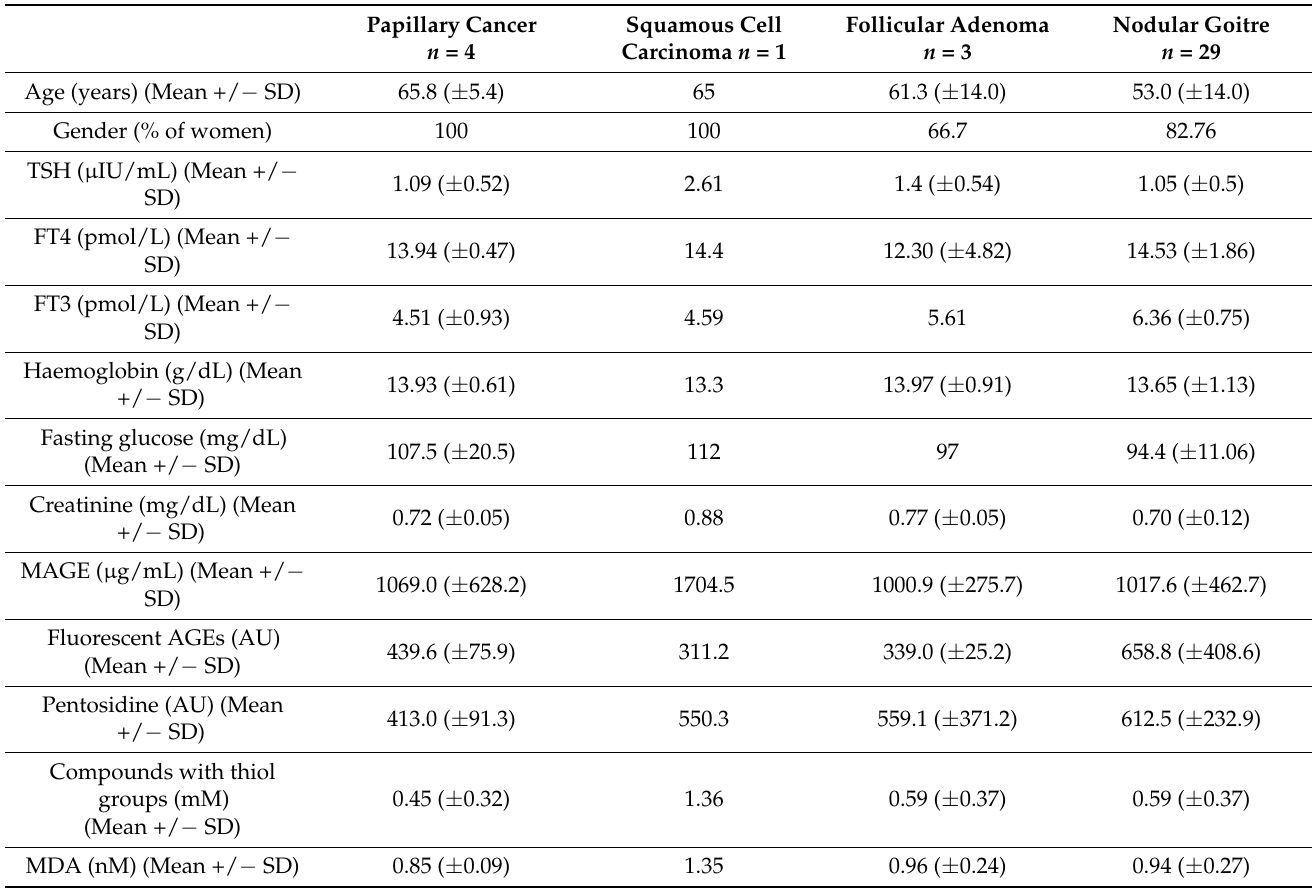
Table 1. Characteristics of the study